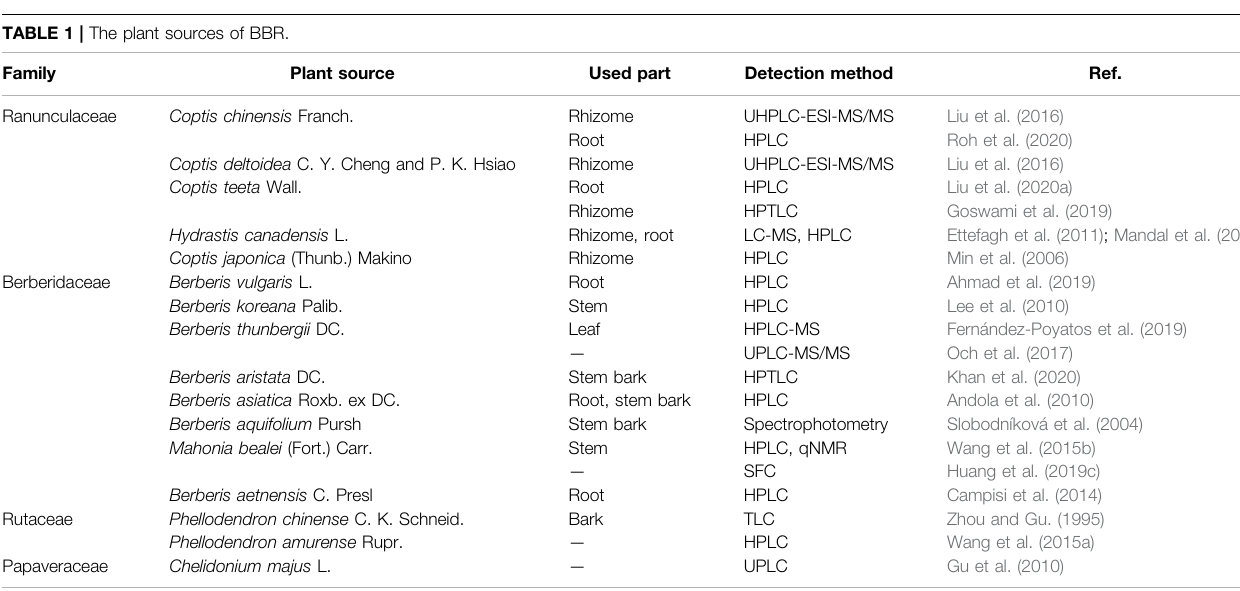
TABLE 1 | The plant sources of BBR.